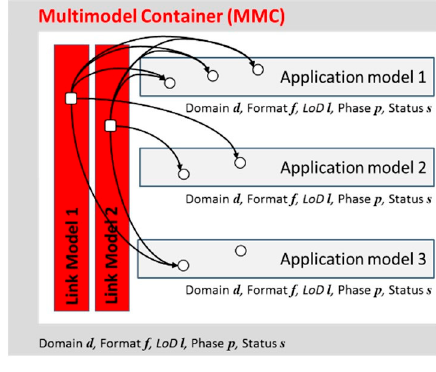
Figure 1. Schematic content of a Multimodel Container including Application Models and Link